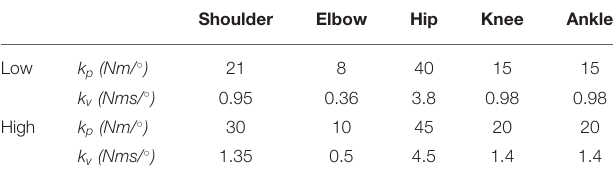
TABLE 1 | Impedance